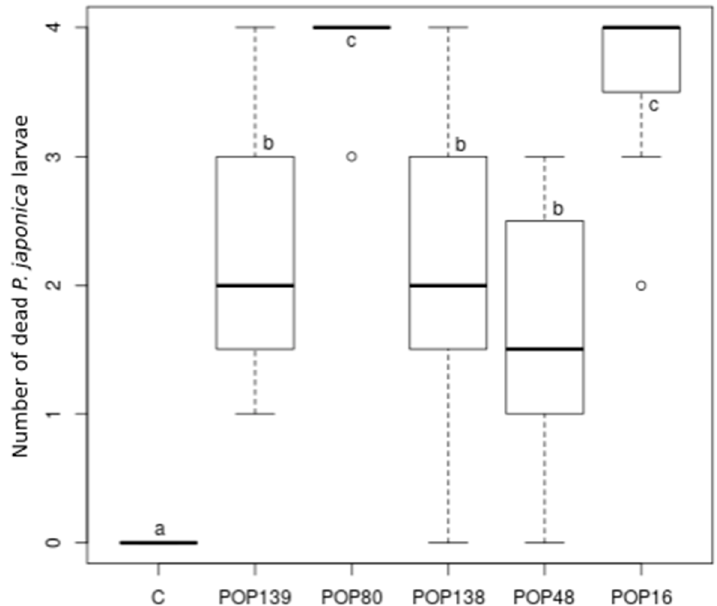
Figure 2. Number of Popillia japonica larvae killed by different entomopathogenic nematode isolates (C: control; POP 139: Steinernema carpocapsae ; POP 80: S. carpocapsae + Heterorhabditis bacteriophora; POP 138: S. carpocapsae + S. feltiae; POP 48: S. feltiae ; POP 16: H. bacteriophora ). Different letters indicate significant differences among treatments.